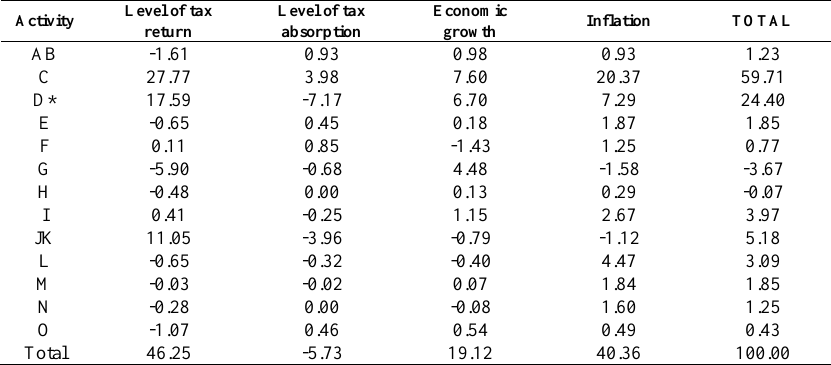
Table 3. The contribution of economic activities and their determinants to the inter-regional differences in tax revenue growth